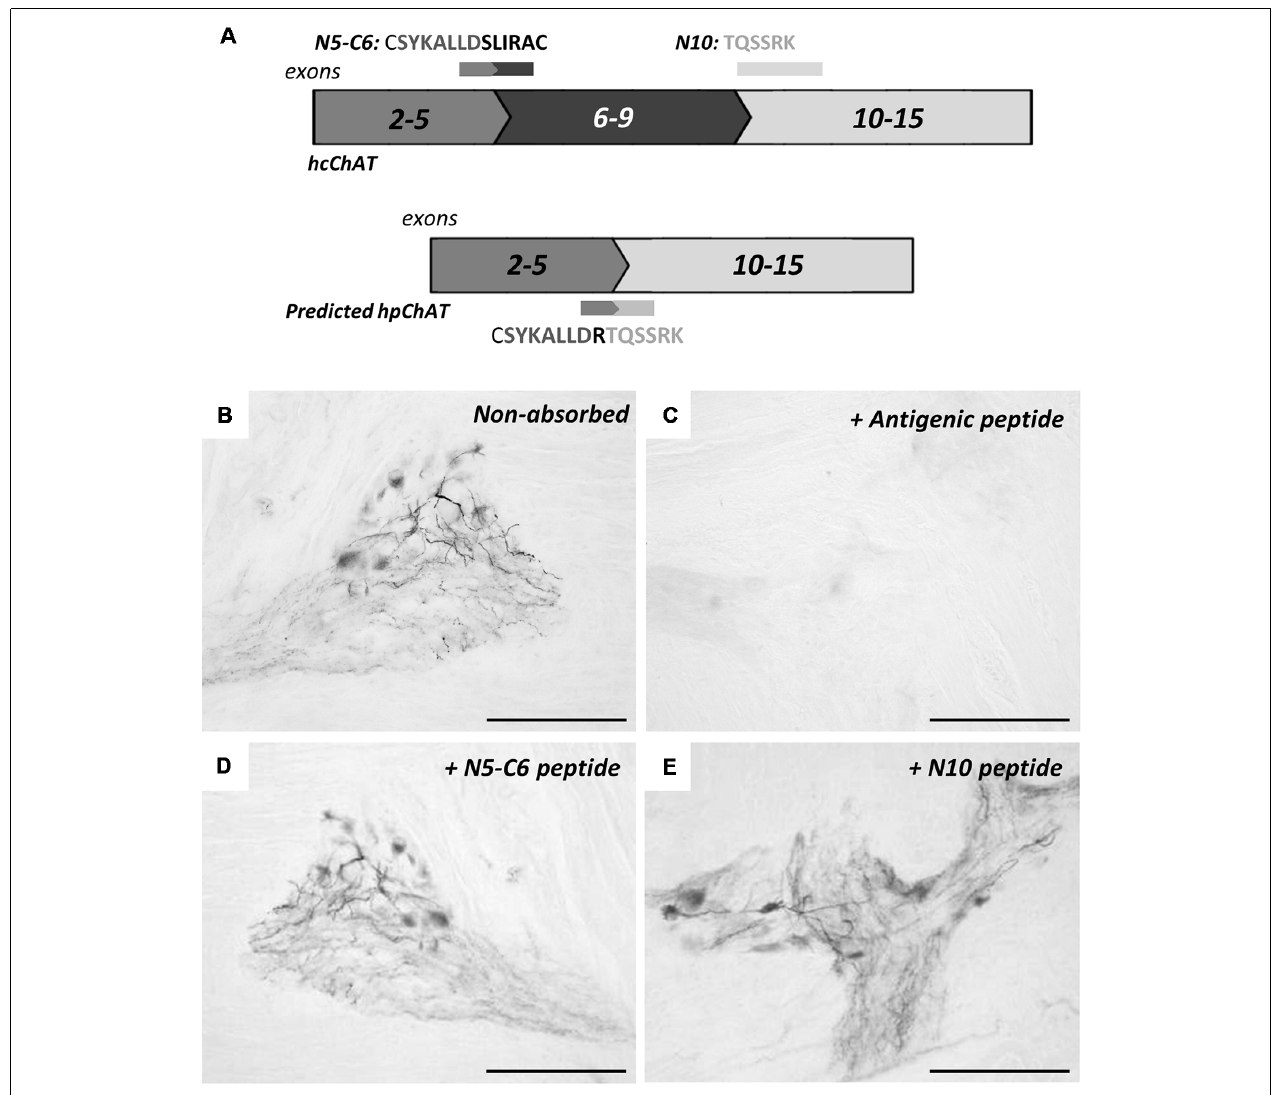
FIGURE 4 | Immunohistochemical absorption test for hpChAT antiserum. Panel (A) shows three peptide absorbents chosen; two (C5-N6 and N10) from the full-length spliced exon sequence coding for hcChAT protein (upper panel), and the antigen peptide (see Figure 1 ) from the splice variant coding for predicted hpChAT protein (lower panel). The exon number is shown in each box. Staining results in the colon using anti-hpChAT antiserum (diluted 1:40,000) alone (B) , pre-incubated with the antigen (C) , C5-N6 peptide (D) and N10 peptide (E) . Bars = 150 µ